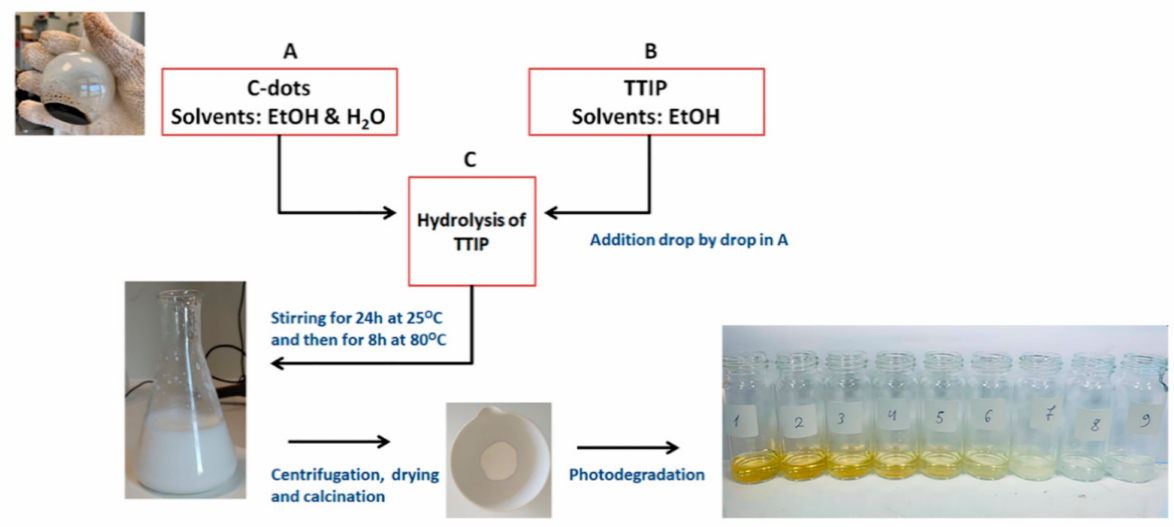
Figure 1. Synthesis route of TiO 2 enriched with